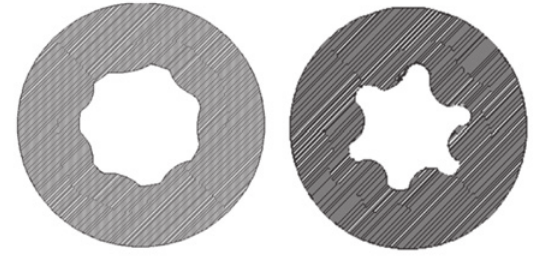
Fig. 9. 7-pointed rose petal grain configuration, 6-pointed star grain configuration